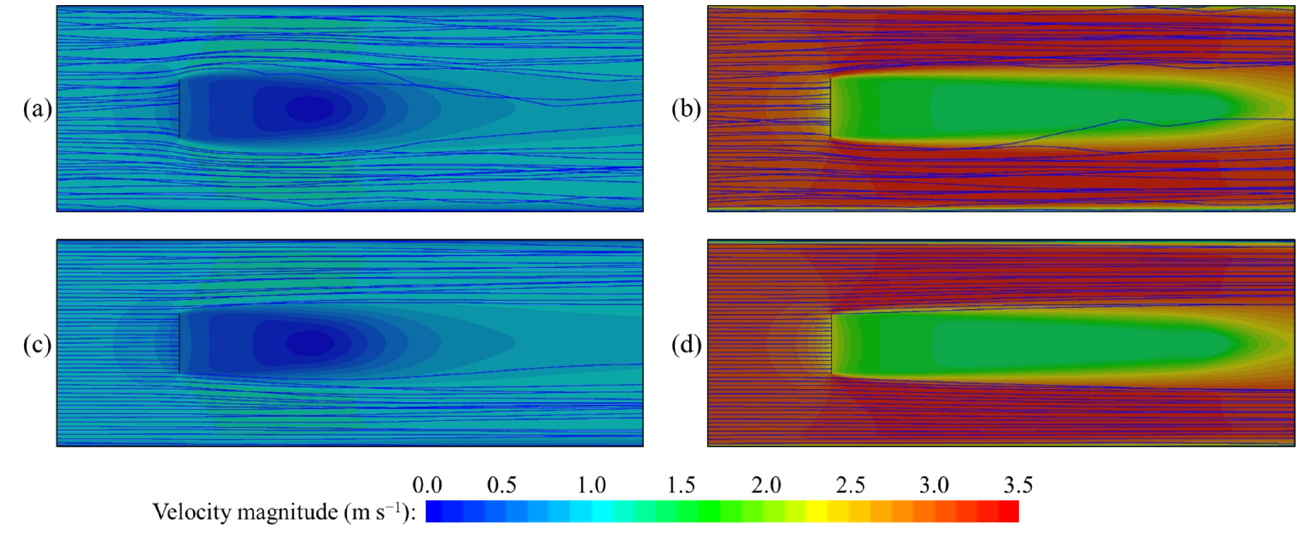
Figure 4. Velocity magnitude distribution around the nylon screen (contours) and the entrained droplets’ trajectories (lines) according to the wind speed and droplet diameter: ( a ) wind speed = 1 m s -1 , droplet diameter = 40 μ m; ( b ) wind speed = 3 m s -1 , droplet diameter = 40 μ m;. ( c ) wind speed = 1 m s -1 , droplet diameter = 360 μ m; ( d ) wind speed = 3 m s -1 , droplet diameter = 360 μ m.